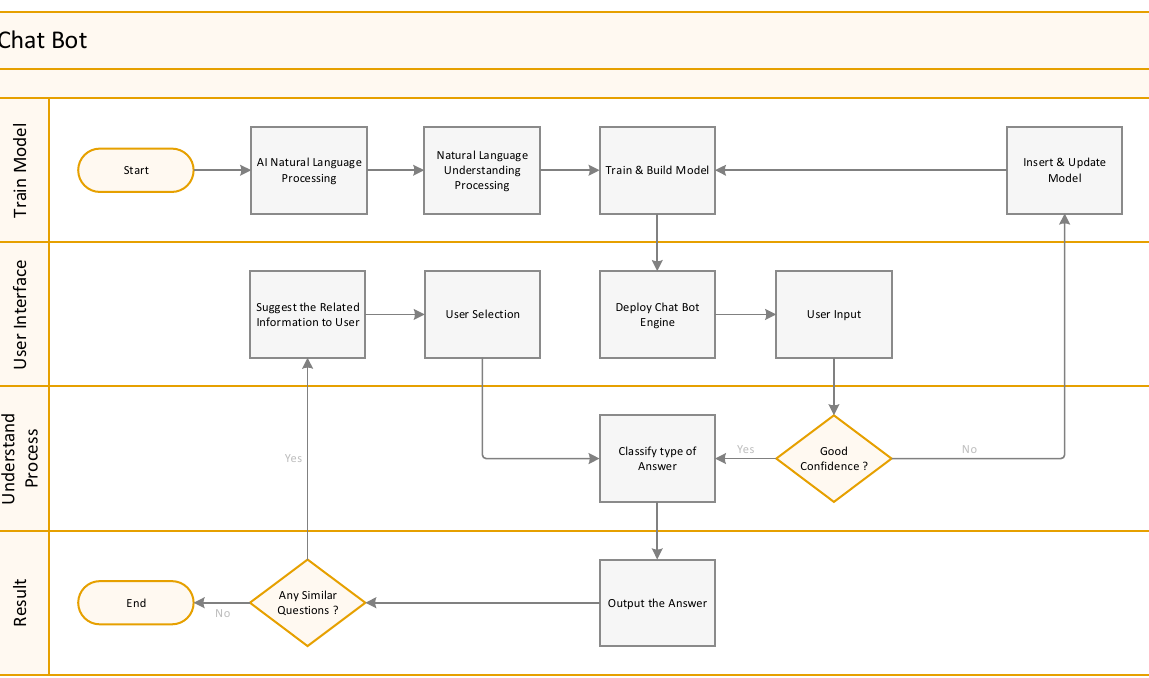
Figure 8. Process of defining Utterance.